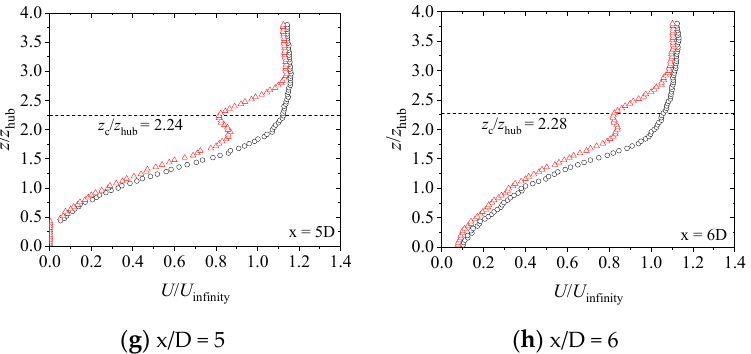
Figure 11. A detailed comparison of the wake with the wind turbine located 2D in front (case 3, x/D = − 1 to 6).